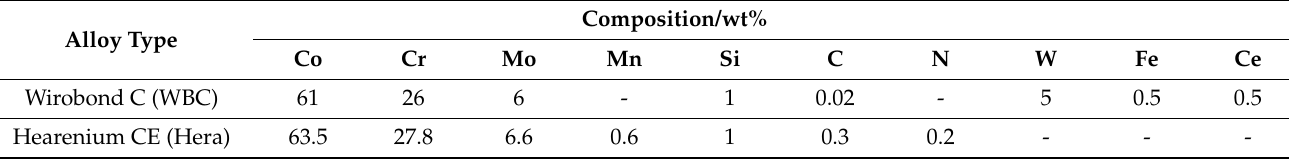
Table 1. Chemical composition of the CoCr